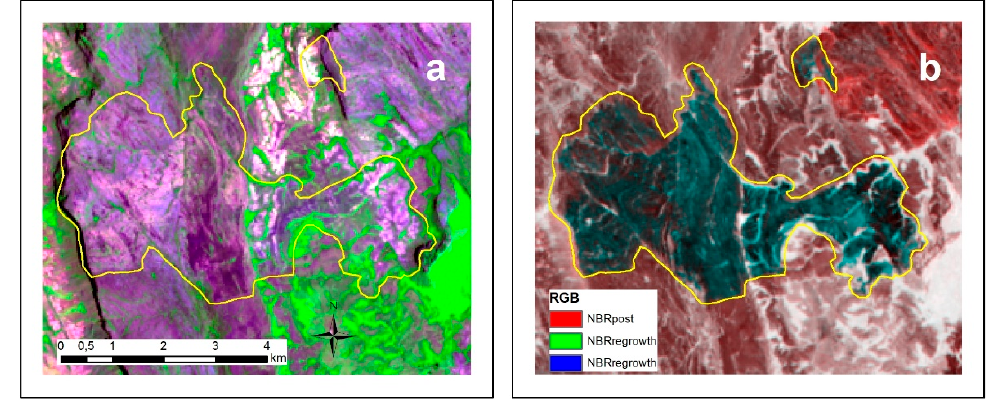
Figure 5. Pictures of: ( a ) colored composition image corresponding to the regrowth image for the Gerais do Vieira fire, data from the Landsat-8 7-5-4 RGB OLI sensor and ( b ) multitemporal visualization of the regrowth area (2016) corresponding to the Gerais do Vieira fire, RGB NBRpre, NBRpost, and NBRregrowth.